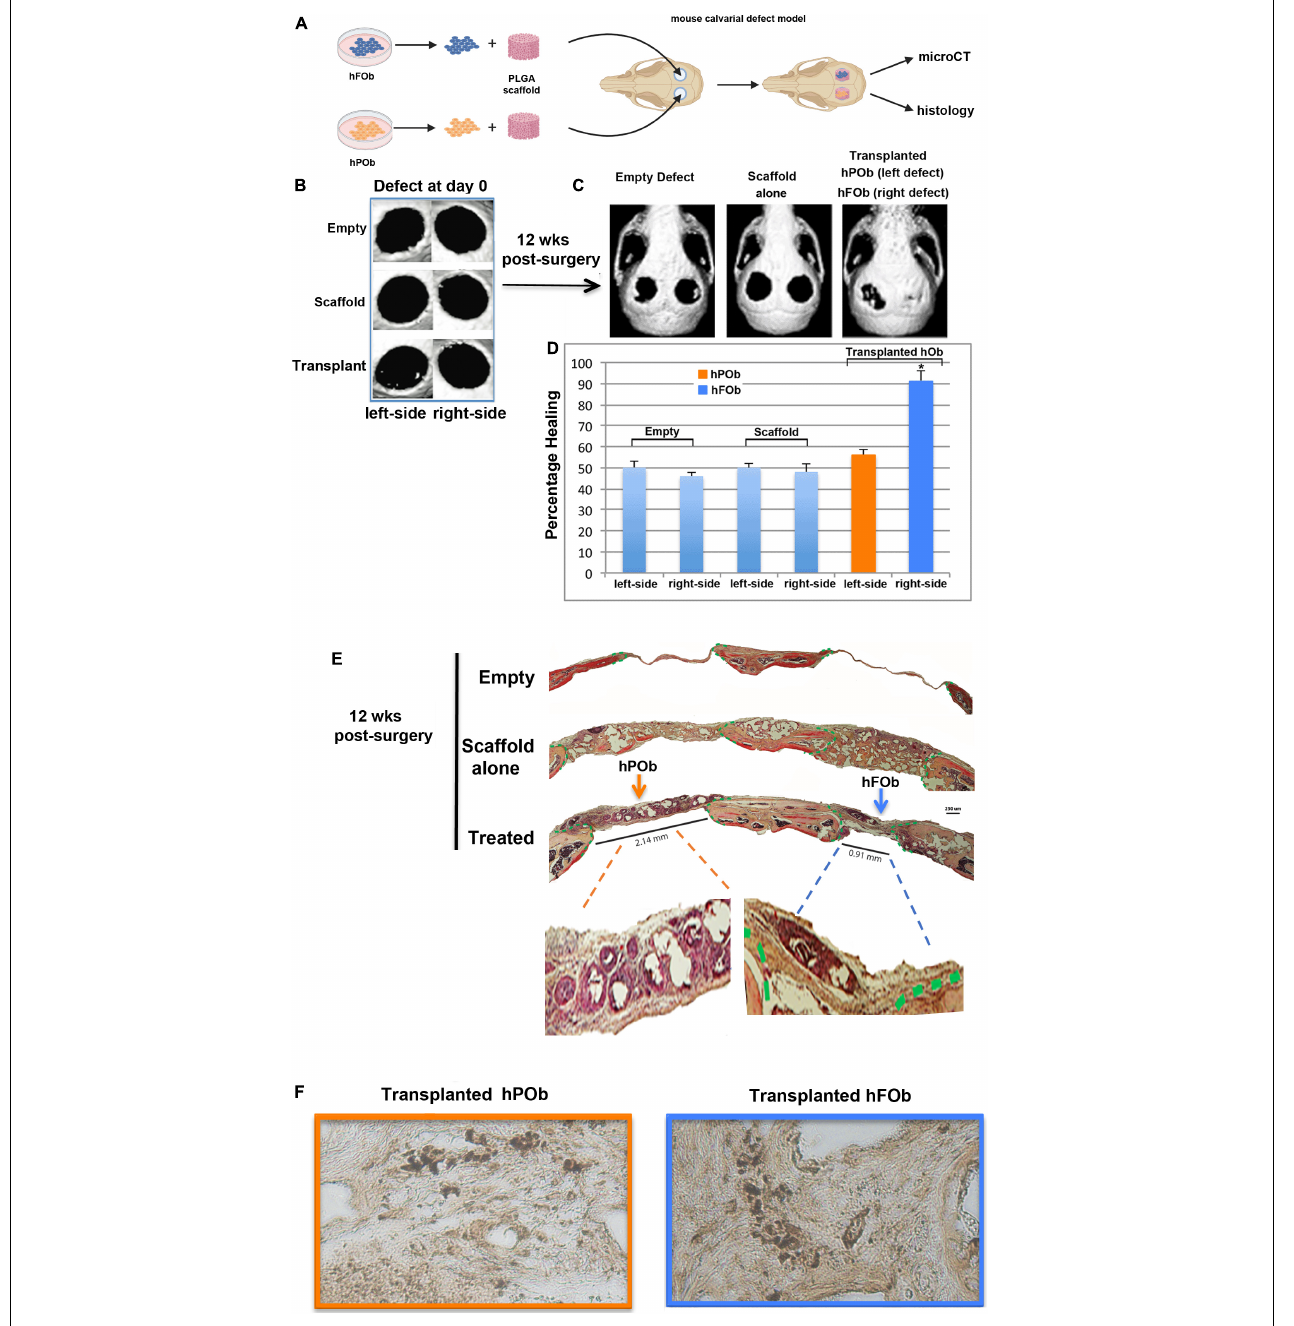
FIGURE 2 | In vivo transplanted hFOb and hPOb feature different osteoskeletal regenerative ability. (A) Cartoon depicting the scheme of the experimental procedures. (B) Representative images of micro-CT ( µ CT) acquired at day 0 (24 h upon defects creation Four-millimeter calvarial defects were created on both sides of parietal bone in 9-weeks old CD-1 nude mice ( n = 5/each group). Defects were treated with a PLGA scaffold loaded either with hFOb (right side) or hPOb (left side), number of transplanted cells was 2.5 × 10 5 . Animal groups with empty defect or PLGA scaffold alone were implemented as control to assess the extent of endogenous bony tissue repair. (C) Skull defects regeneration images obtained by µ CT analysis at 12-weeks post-surgery. (D) Quantification of bone regeneration determined by µ CT at 12-weeks post-surgery. For statistical analysis, empty group and scaffold alone group was compared with other groups using the Mann-Whitney U -test. A * p -value < 0.05 was considered statistically significant. (E) Pentachrome staining of coronal sections showing healing in parietal defects treated with transplanted hFOb, neo-formed bony-tissue (yellow-color) bridging the calvarial defect edges can be appreciated. Conversely defects treated with POb did not promote any bony tissues formation. Green dashed lines mark the osteogenic fronts surrounding the defects. Pentachrome stains bony tissue in yellow. Scale bar values 250 µ m. (F) Human nuclear antigen staining detecting the presence of both hFOb and hPOb within the area of calvarial defects creation at 12-weeeks